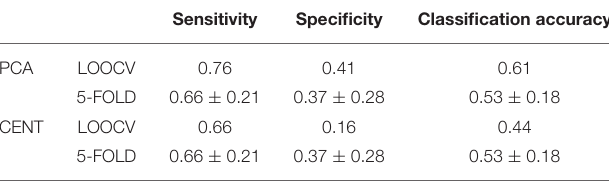
FCG based on both ROI representation schemes for the CorrEnv. Both PCA/Centroid ROI approach reveal frontal, precuneus ( Figure 5A ). Centroid ROI scheme revealed bilateral temporo-parietal hemispheric connections, fronto-parietal, frontal connections involving right precuneus that improved the classification performance between the two groups ( Figure 5B